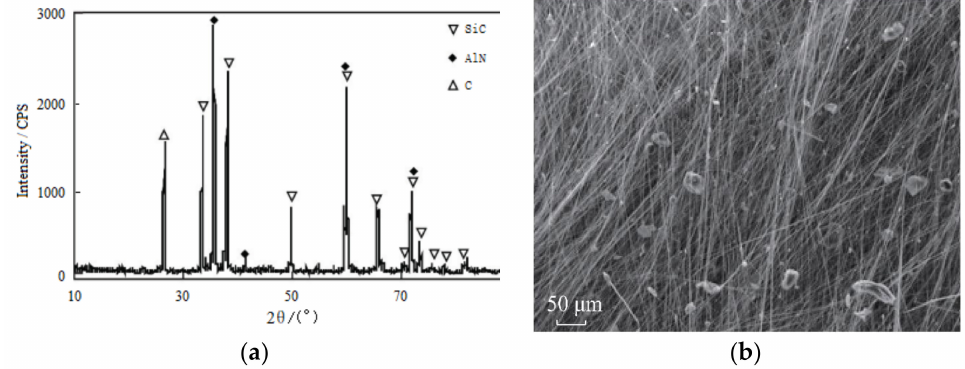
Figure 8. XRD pattern and SEM image of condensate; ( a ) XRD patterns of condensate, ( b ) SEM image of